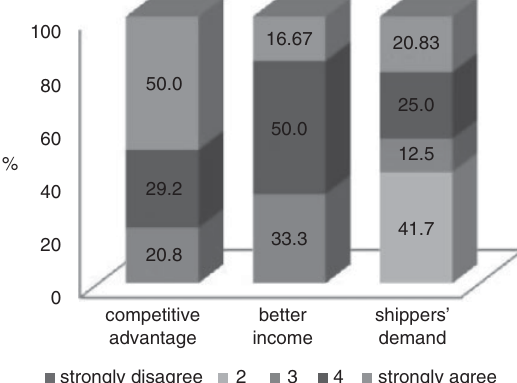
Fig. 8. Current offer of an innovative approach